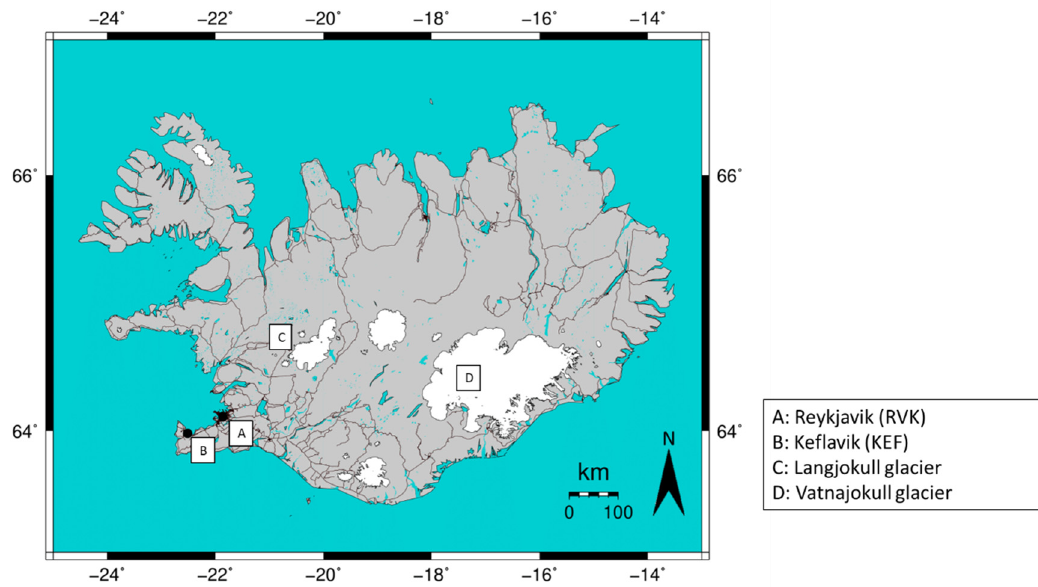
Figure 1. Observation sites ( A and B ) used in this study. Detailed coordinates and instruments can be found in Table 1. C and D indicate the location of Langjokull and Vatnajokull glaciers. Table 1. The dates, locations and instrumentation available during the two events described in this